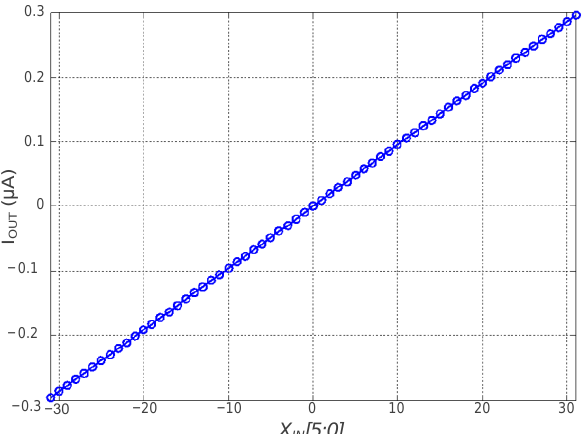
Figure 9. Simulated results of the input current digital-to-analog converter (DAC).